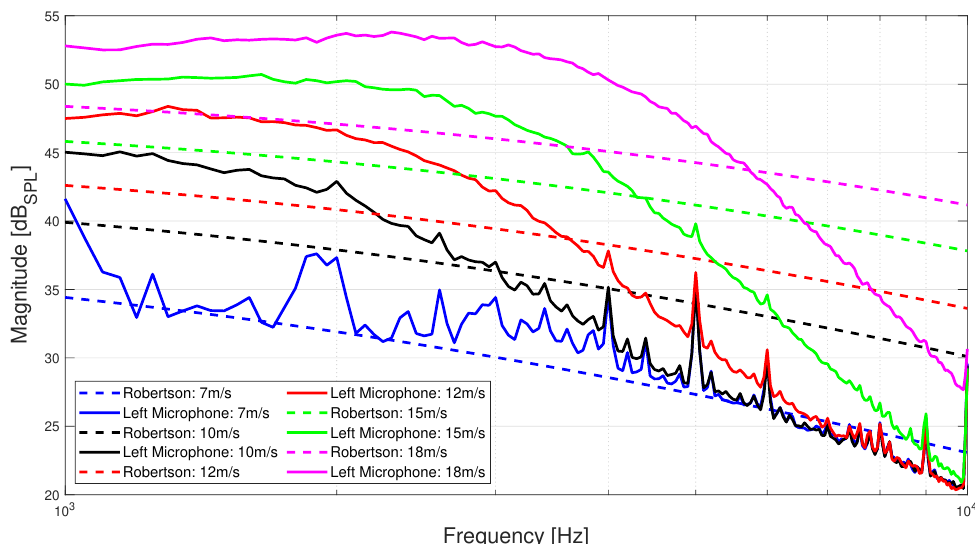
Figure 9. PSDs expressed in dB SPL of wind tunnel data for the left-mounted microphone wind for motor configuration D and AoA of 0 ◦ (solid lines) and those predicted by the Robertson model under the same conditions (dashed